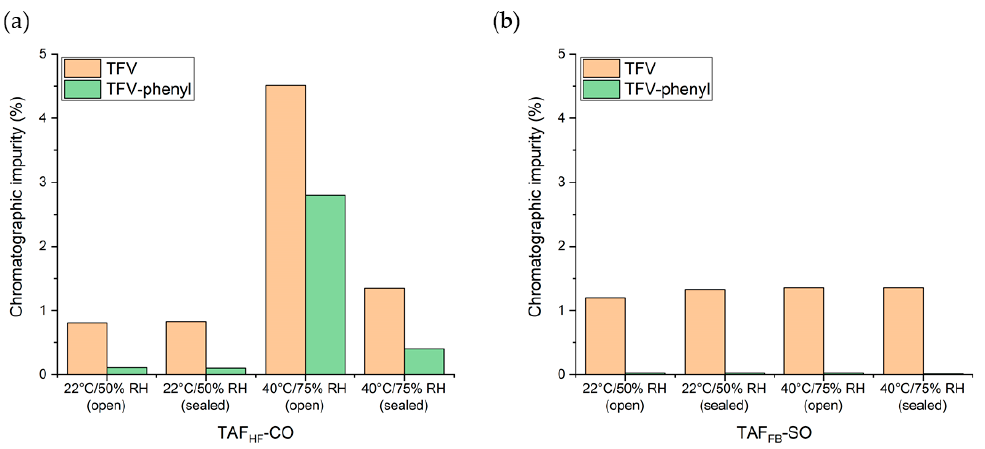
Figure 9. Chromatographic impurity of TAF HF -CO ( a ) and TAF FB -SO ( b ) formulations within the implant at 180 days under various storage conditions.